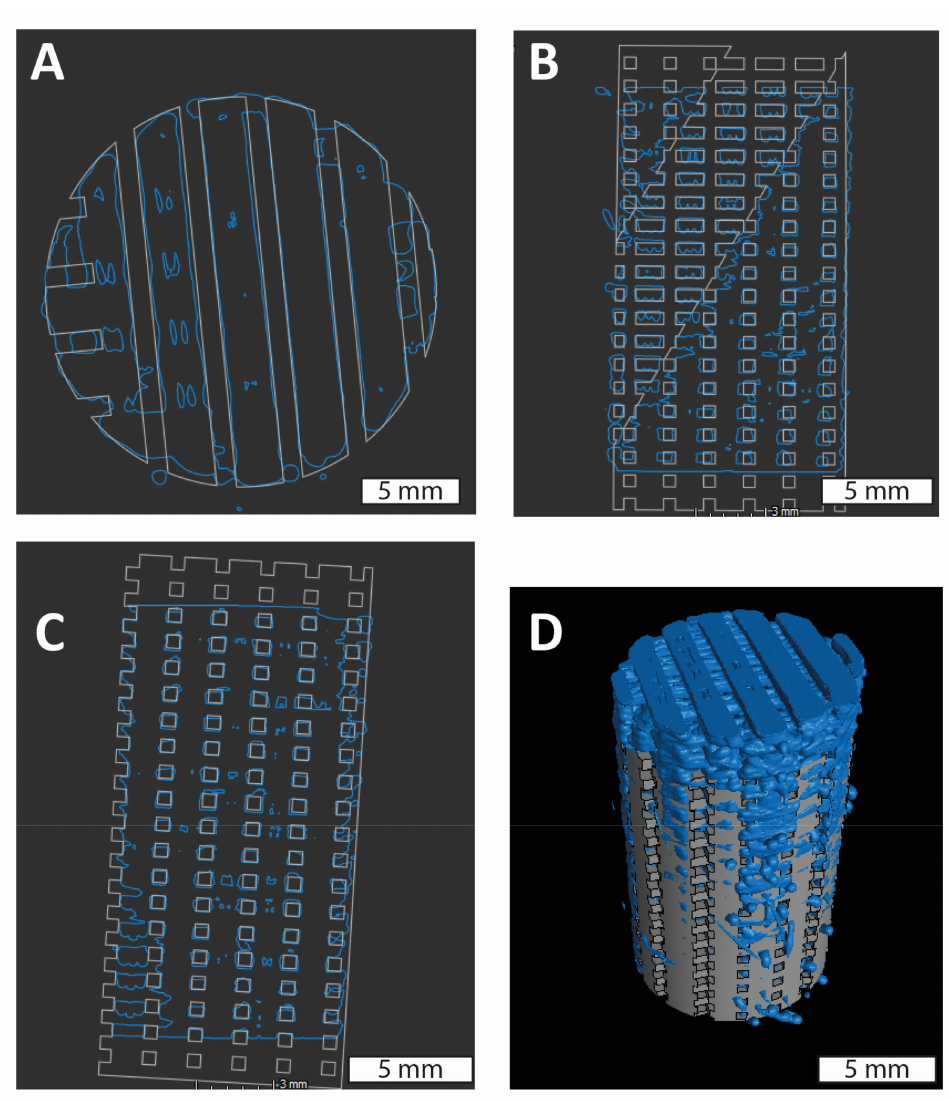
Figure 3. Qualitative evaluation of the accuracy of a printed specimen geometry versus theoretical CAD design: A comparison between the CAD model (grey) and the acquired volume with micro CT data (blue). ( A ) A cross-sectional plane at the midpoint along the horizontal plane showing the inner correlation; ( B ) along central vertical plane; ( C ) along the vertical plane with a small angle of rotation; and, ( D ) Isometric view of micro CT data (blue) and CAD model (grey)